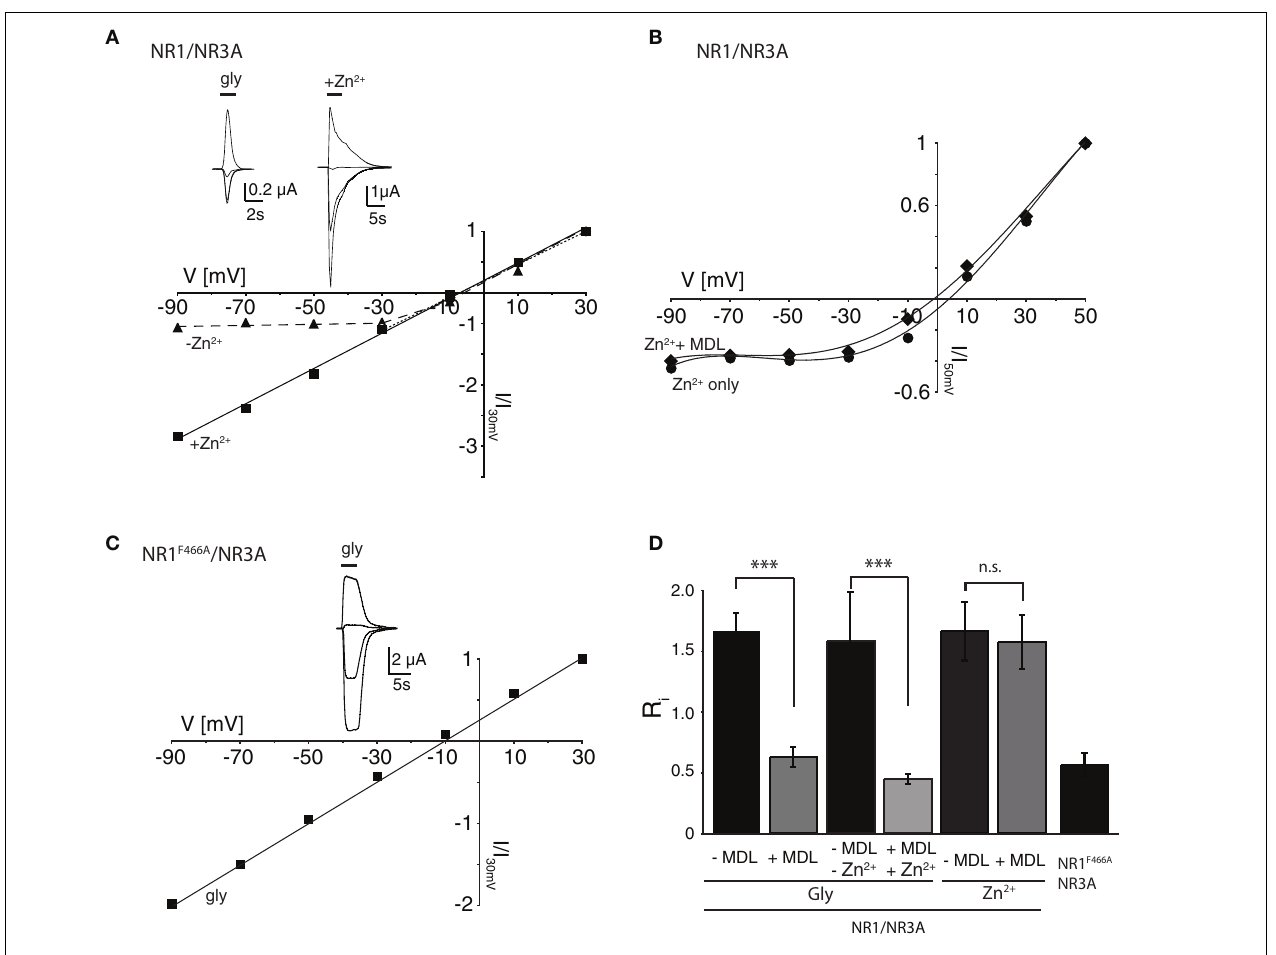
FIGURE 2 | Zn 2 + mediated effects at NR1/NR3A receptors. (A) Zn 2 + potentiation of glycine-induced currents at NR1/NR3A receptors. Normalized I–V plot of NR1/NR3A receptor currents activated by a saturating glycine concentration in the absence (triangle) and presence (square) of 50 µM Zn 2 + . Similar to MDL, also co-application of 50 µM Zn 2 + with 100 µM glycine causes a linearization of NR1/NR3A receptor I–V relationship. (B) MDL potentiation of Zn 2 + -induced currents at NR1/NR3A receptors. Normalized I–V plot of NR1/NR3A receptor currents activated by a saturating Zn 2 + concentration in the absence